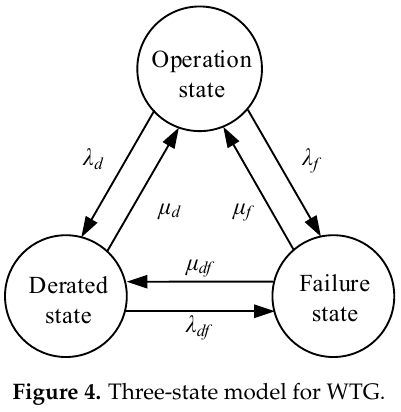
Figure 4. Three-state model for WTG.